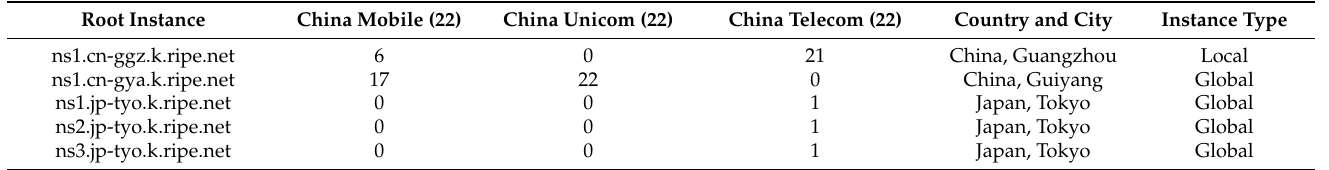
Table 2. Statistics of K root anycast nodes requested by three operators.